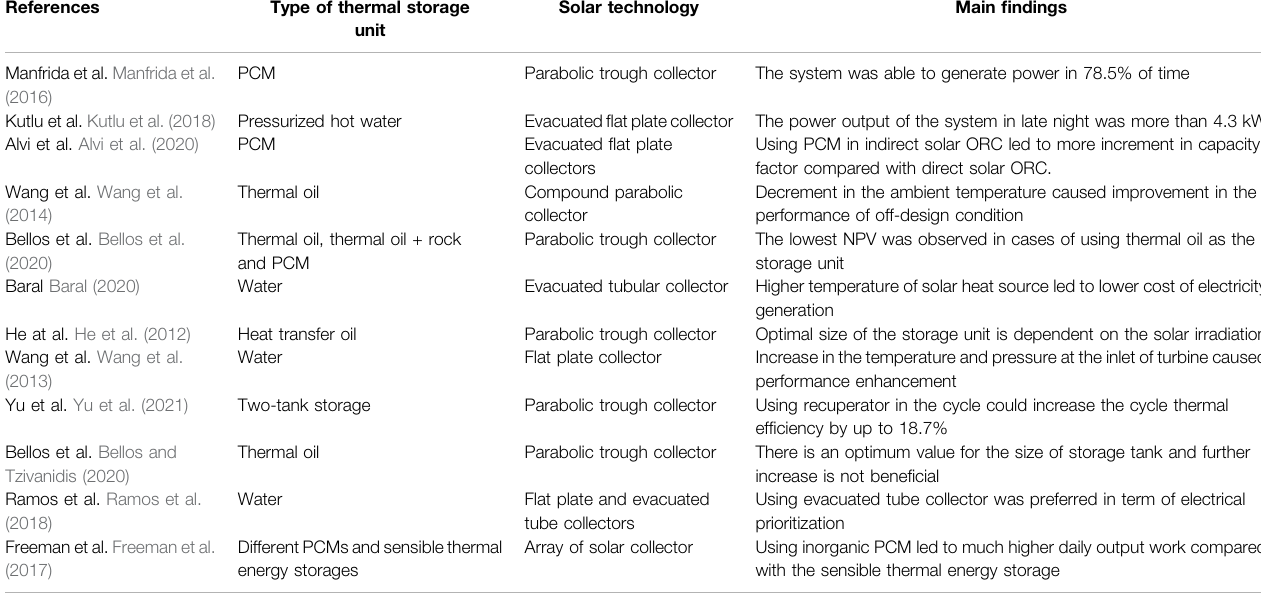
TABLE 3 | Summaries of the works on the solar ORCs with storage